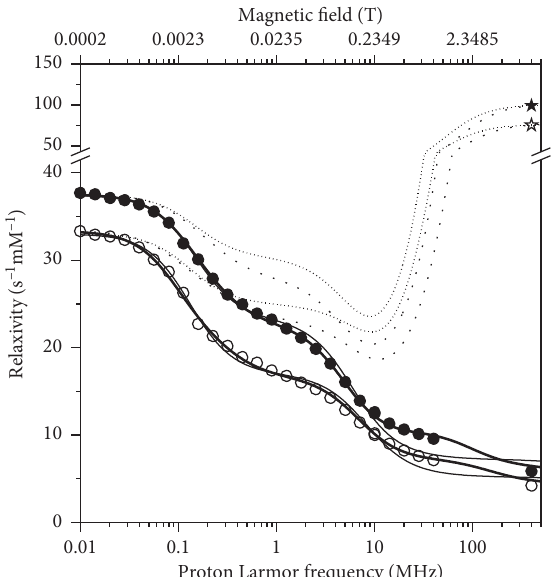
Figure 1: Experimental 1 H R 1 H R 1 profiles (circles) and 2 at 400MHz Figure 2: 1 H longitudinal relaxivity profiles (circles) and transverse (stars) of pineapple juice at 25 ° C (solid symbols) and 37 ° C (empty relaxivity at 400MHz (stars) of Mn 2+ ions in pineapple juice at 25 ° C symbols). The dotted and dashed lines represent estimates of the (solid symbols) and 37 ° C (empty symbols). The solid and dotted diamagnetic contribution and of the latter summed to the R 1 con- lines represent the best fit profiles of the longitudinal and transverse tribution from iron ions at 37 ° C, respectively; the dotted-dashed red relaxivities, respectively. The thin lines refer to the fit without line provides an estimate of the contributions to R 2 from diamagnetic inclusion of the order parameter S 2 LS . relaxation and from transverse relaxation of iron ions at 37 °